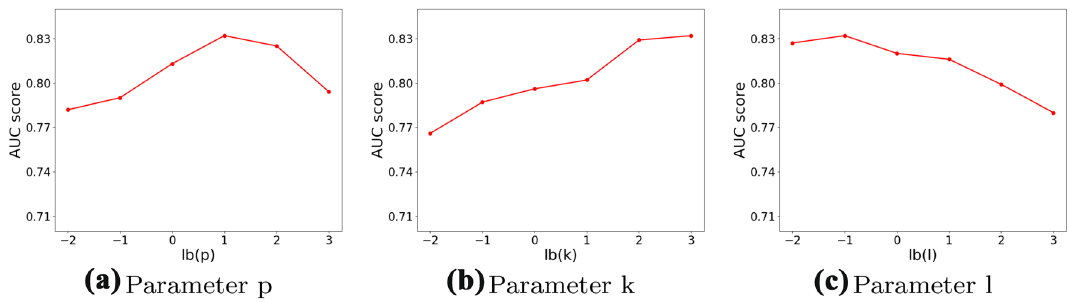
Fig. 9 Parameter sensitivity